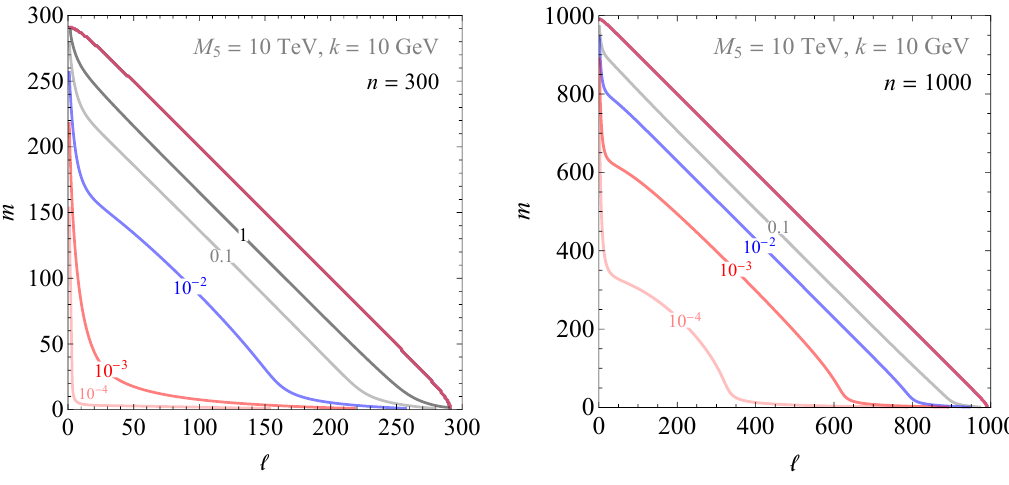
Figure 20 . Contours of the partial width for a KK graviton mode n to decay to a pair of modes ‘ and m , (cid:0) G , normalized by (cid:0) =n 2 . The example shown is M 5 = 10 TeV, k = 10 GeV, G n ! P G ‘ G m n ! G ‘ G m for mode n = 300 (left) and n = 1000 (right). The masses of these modes are m 300 (cid:25) 318 GeV and m 1000 (cid:25) 1059